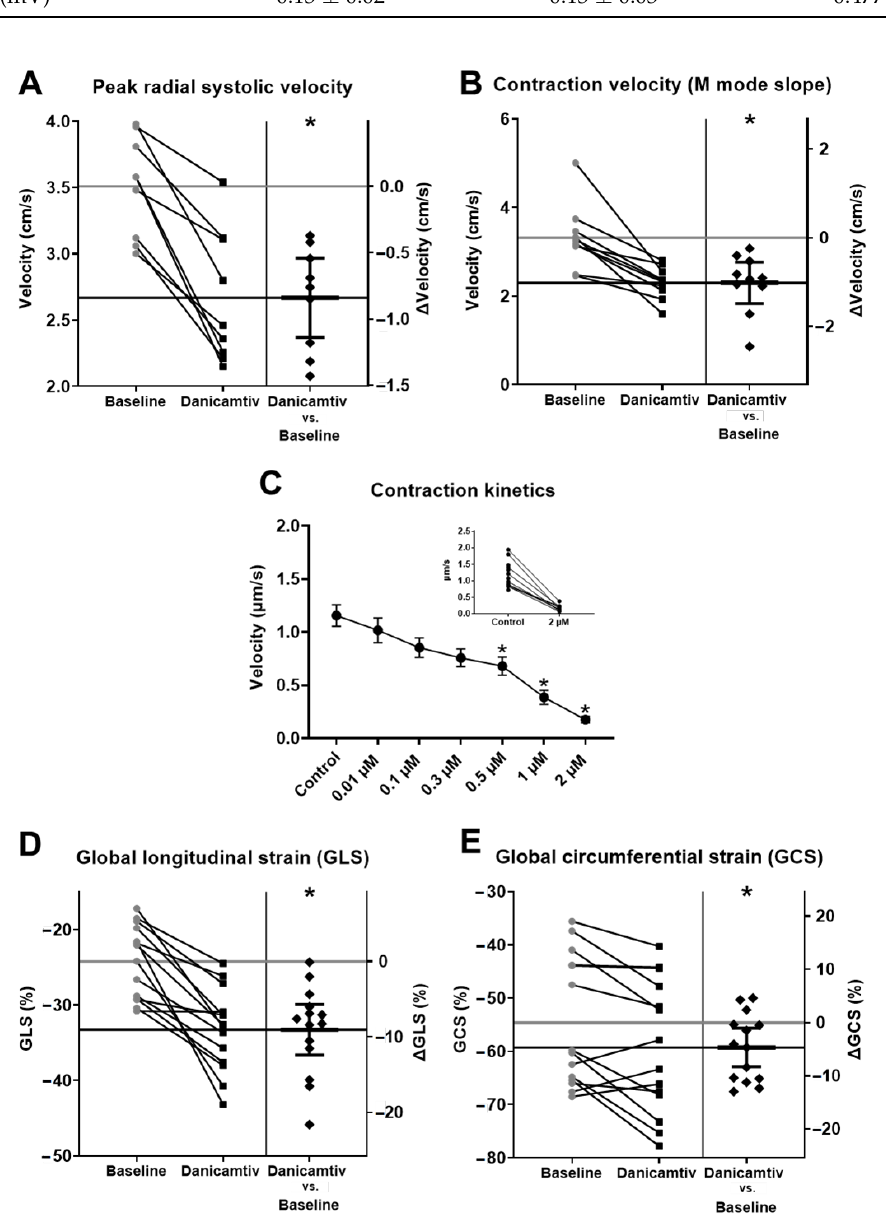
Figure 4. Danicamtiv decreased LV and cardiomyocyte contraction kinetics. The LV peak radial systolic velocity and contraction velocity (M-mode slope) decreased significantly upon danicamtiv administration ( A , B ). Cardiomyocyte contraction kinetics were also slowed down by danicamtiv ( C ). Global longitudinal and circumferential strain were decreased significantly by danicamtiv ( D , E ). (The construction of panels is identical with the corresponding ones in Figure 1). * = p < 0.05.